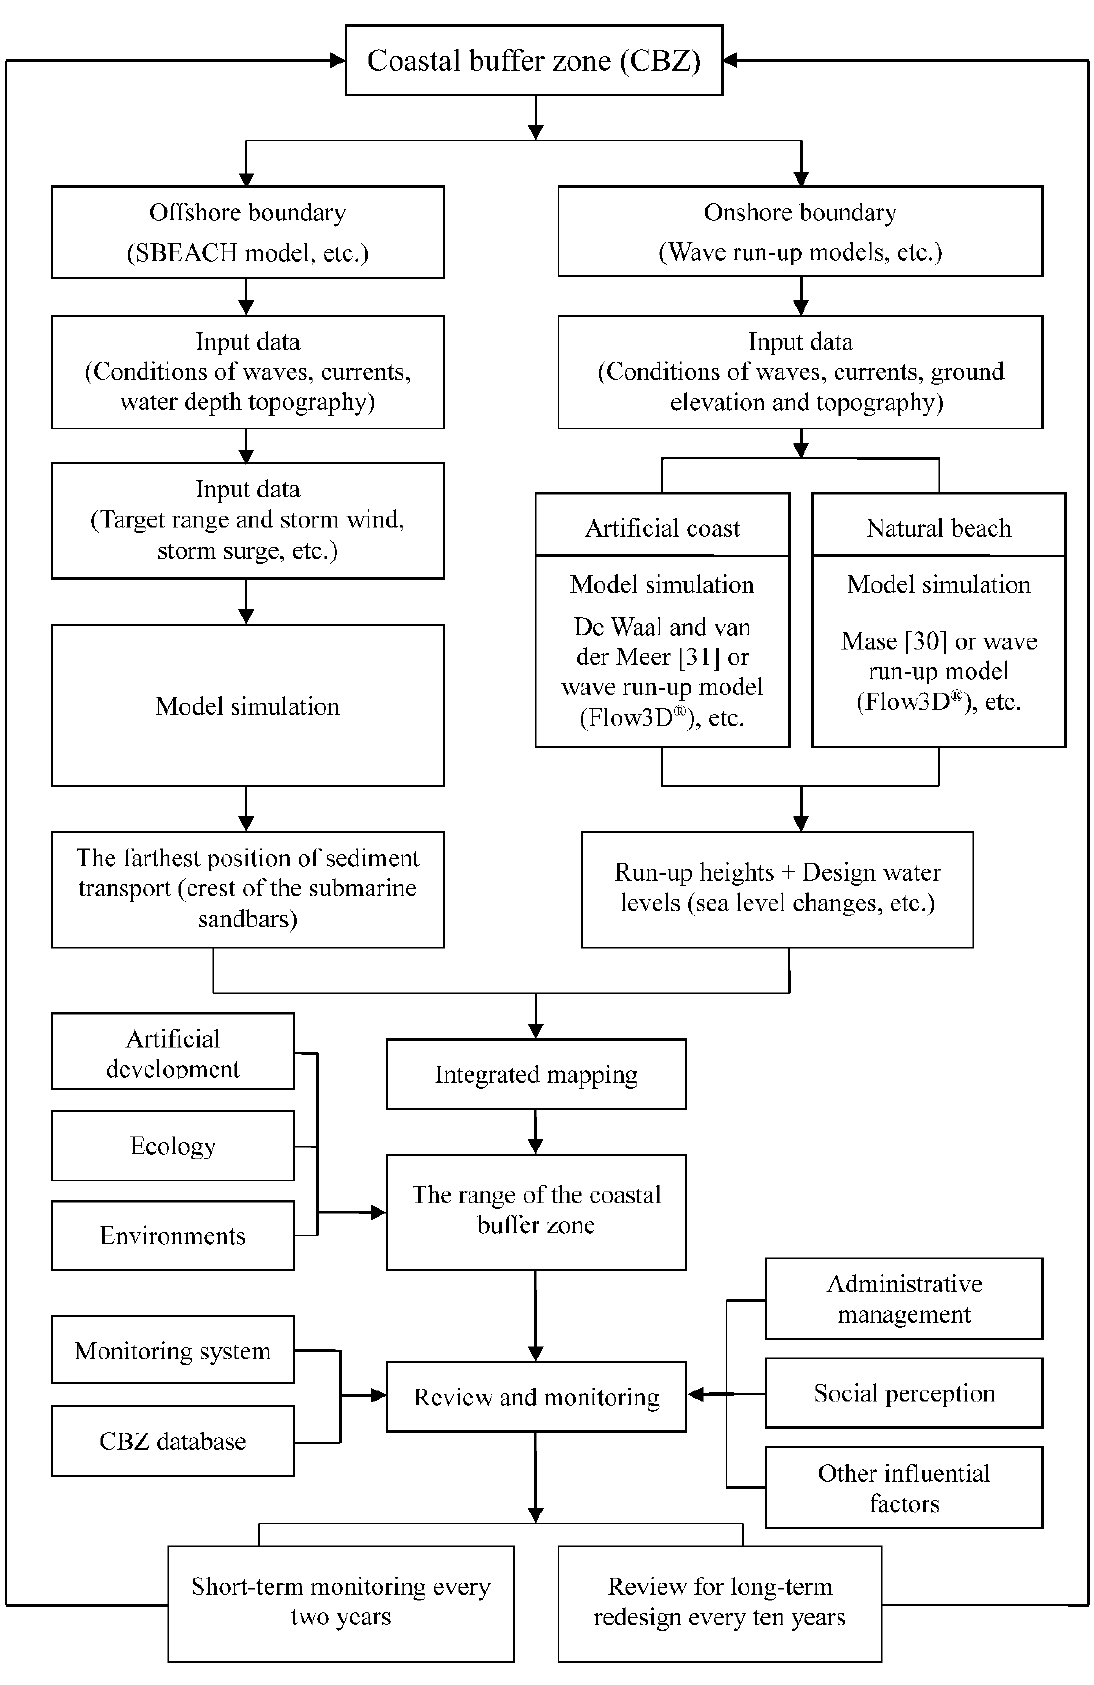
Figure 7. Recommended flow chart to design coastal buffer zones for coastal managers.